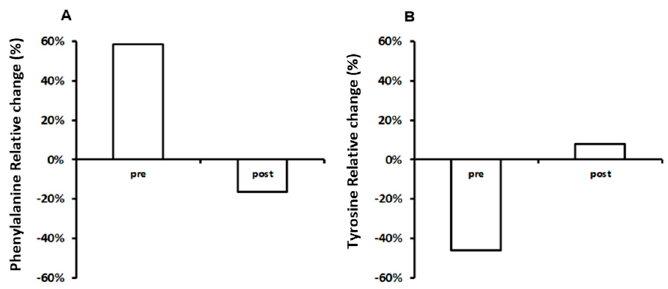
Figure 3. ( A ) Mean relative di ff erences of HIV negative individuals from normal level of phenylalanine. The phenylalanine concentration has been measured in the pre (T0) and post (T6) treatment of probiotics. ( B ) Relative di ff erences in percentage of HIV negative subjects from normal values of tyrosine. The tyrosine has been measured in the pre (T0) and post-treatment (T6). Average (grey: untreated; white: treated).